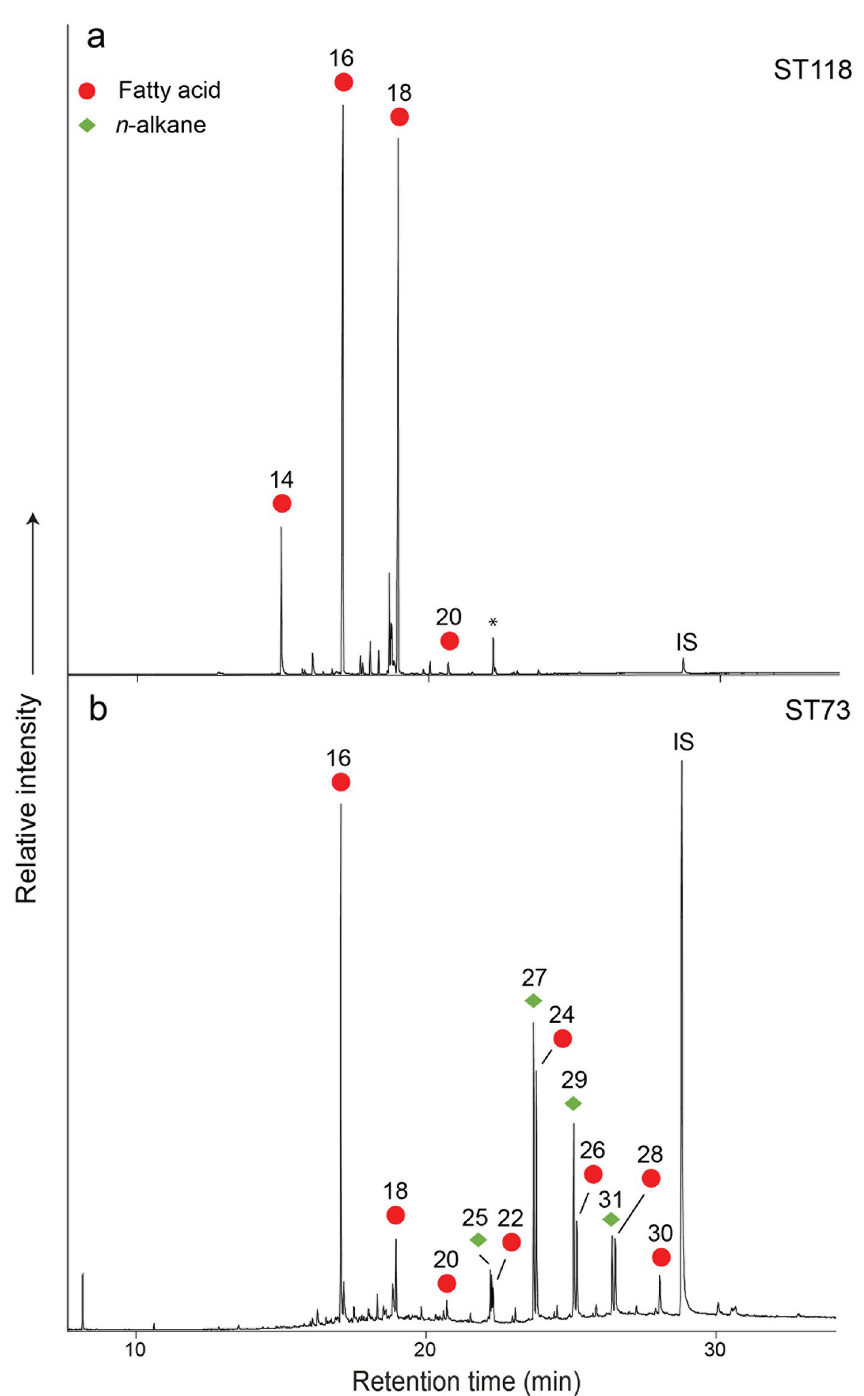
Fig 2. Partial gas chromatograms of trimethylsilylated Fatty Acid Methyl Esters (FAMEs) from Star č evo-Grad. a: potsherd ST118, showing a typical degraded animal fat profile [23,39],dominated by palmitic (C 16:0 ) and stearic (C 18:0 ) fatty acids (shown as red circles). b: potsherd ST73, displaying a series of long-chain fatty acids (red circles) and n - alkanes (green diamond), likely indicative of plant processing. IS indicates the internal standard.